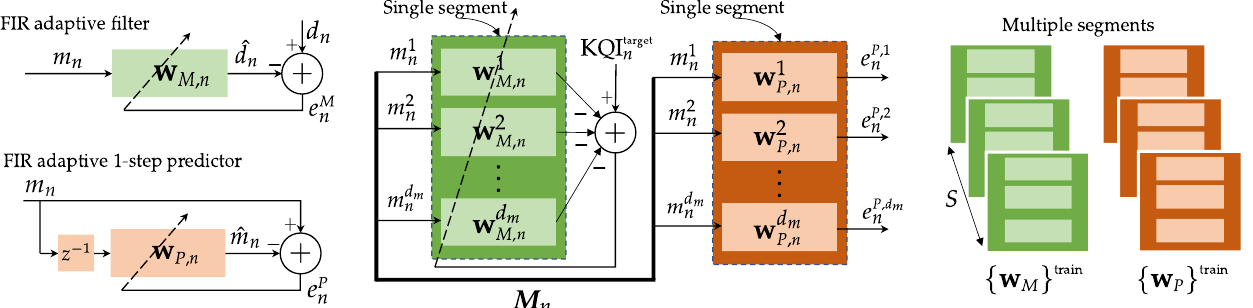
Figure 2. Adaptive filters used to construct representations of the measurement set M n (inputs) and output space (KQIs). Left: representation of a single adaptive filter with external training data d n (top), used as adaptive predictor (bottom); middle: multivariate adaptive filters (KQI mapping and multichannel predictors), for a single time-series segment; right: complete set of filter weights after the training